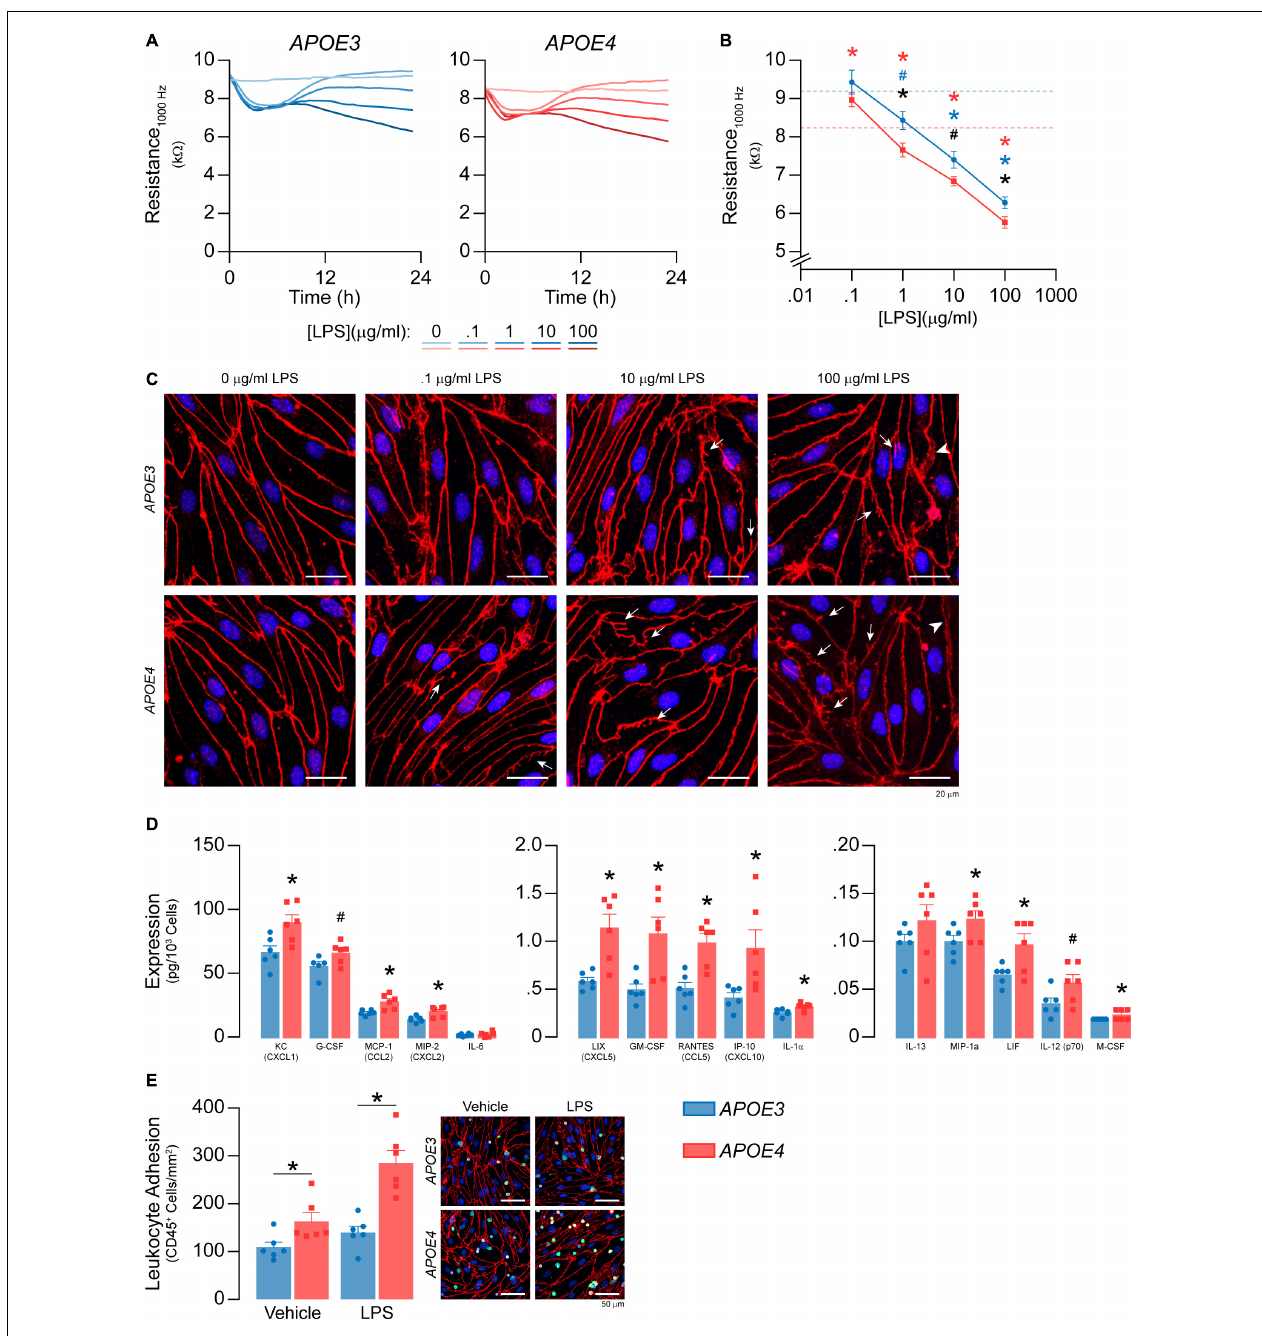
FIGURE 9 | APOE modulates inflammation after LPS treatment. (A,B) LPS was spiked into the media to a final concentration of 100 ng/ml – 100 µ g/ml and TEER was measured over the course of 24 h at 1000Hz. LPS lowers TEER at 1, 10, and 1000 µ g/ml in both APOE3 and APOE4 brain endothelial cells and at these doses, TEER values are higher with APOE3 compared to APOE4 (2-way ANOVA followed by Student’s t -test; APOE3 n = 5, APOE4 , n = 6). Dashed line represents vehicle control for each genotype (i.e., blue is APOE3 and red is APOE4 ). (C) Qualitatively, high doses of LPS also modulate the brain endothelial cell shape, with morphological changes that include abnormal tight junction protein protrusions (white arrows) and separation of tight junctions from neighboring cells (arrow heads). (D) After 24 h of treatment with 100 ng/ml LPS, there are higher levels of KC/CXCL1, G-CSF, MCP-1/CCL2, MIP-2/CXCL2, LIX/CXCL5, GM-CSF, RANTES/CCL5, IP-10/CXCL10, IL-1a, MIP-1a, LIF, IL-12 (p70), and M-CSF. (E) To determine whether APOE modulated immune cell adhesion after LPS treatment (100 ng/ml, 24 h), we modified the leukocyte adhesion assay. Leukocytes were added with a full media change, rather than spiking, to avoid activation by LPS. Therefore, any APOE genotype differences in chemokine and cytokine levels that typically influence immune cell adhesion would be negated during the assay. Nonetheless, there are higher numbers of CD45 + leukocytes adhered to APOE4 brain endothelial cells both with ( ∼ 49%) and without ( ∼ 104%) LPS treatment. Data is expressed as mean ± S.E.M. * p < 0.05 by two-tailed Student’s t -test and # p < 0.05 by one-tailed Student’s t -test; black is APOE4 vs. APOE3 , blue is APOE3 + LPS vs. APOE3 Vehicle, red is APOE4 + LPS vs. APOE4 Vehicle. n = 6 (unless otherwise specified above).